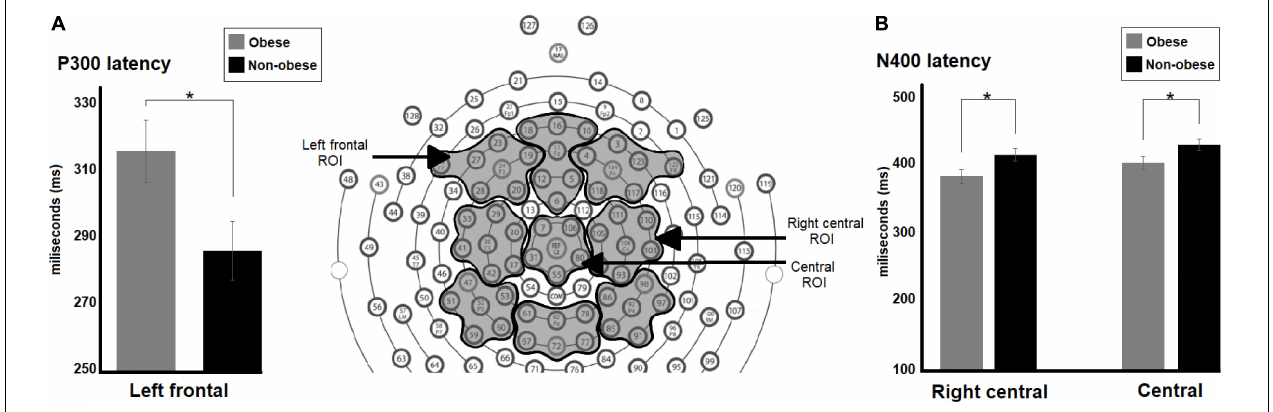
FIGURE 4 | Differences between preteens with obesity and no-obese preteens regardless math skill level in latency of P300 and arithmetic N400 components. In (A) the bar graph shows differences between weight groups in P300 latency in left frontal ROI, the preteens with obesity displayed longer P300 latency than their normal weight peers. In (B) the bar graph illustrates differences between weight groups in N400 latency in right central and central ROIs. The participants with obesity showed shorter N400 latency than the other group in both ROIs. Significant p -values were represented as follows: * p <